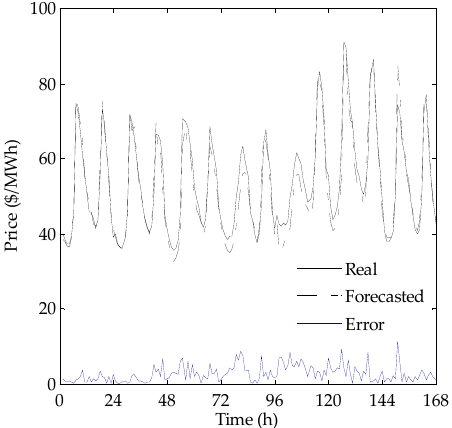
Figure 11. February, 22nd–28th, 2006 results for the PJM (Pennsylvania ‐ New Jersey ‐ Mary) land market.